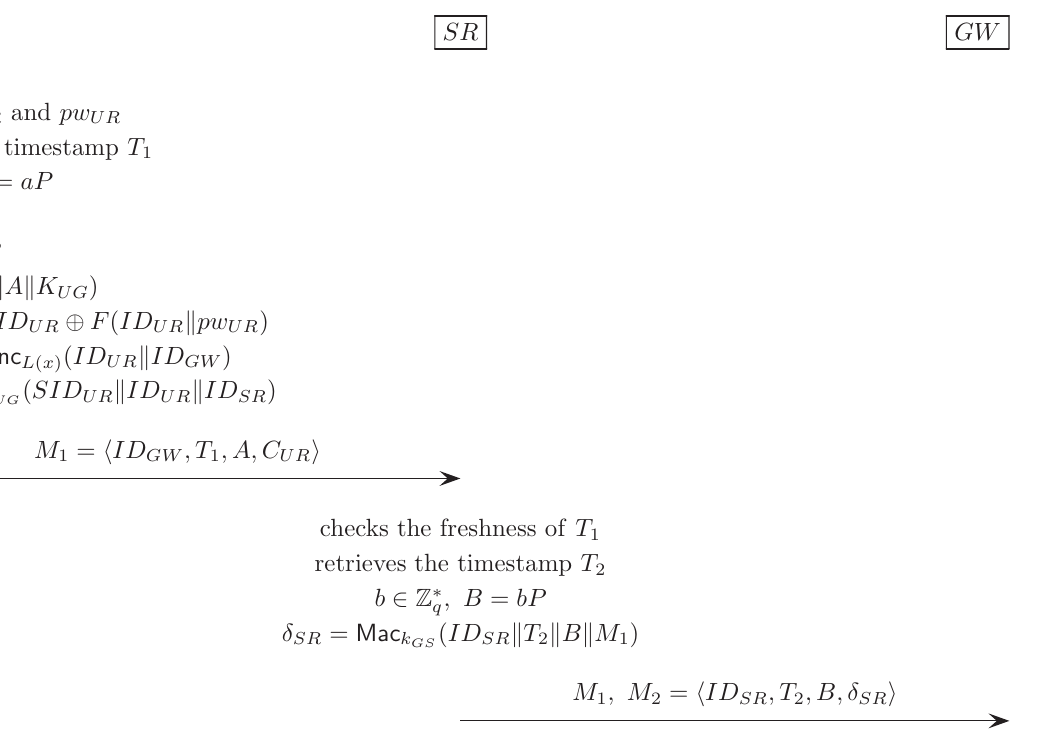
Figure 2. The authentication and key exchange